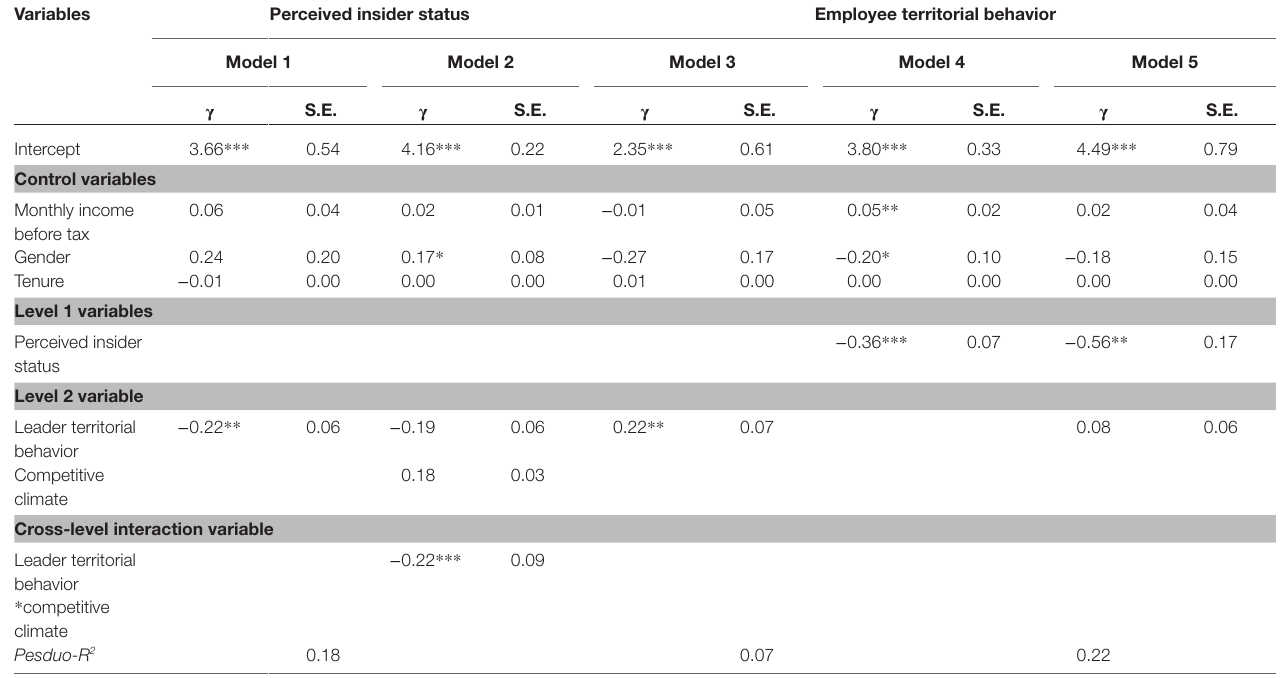
TABLE 5 | Results of multiple regression analysis.